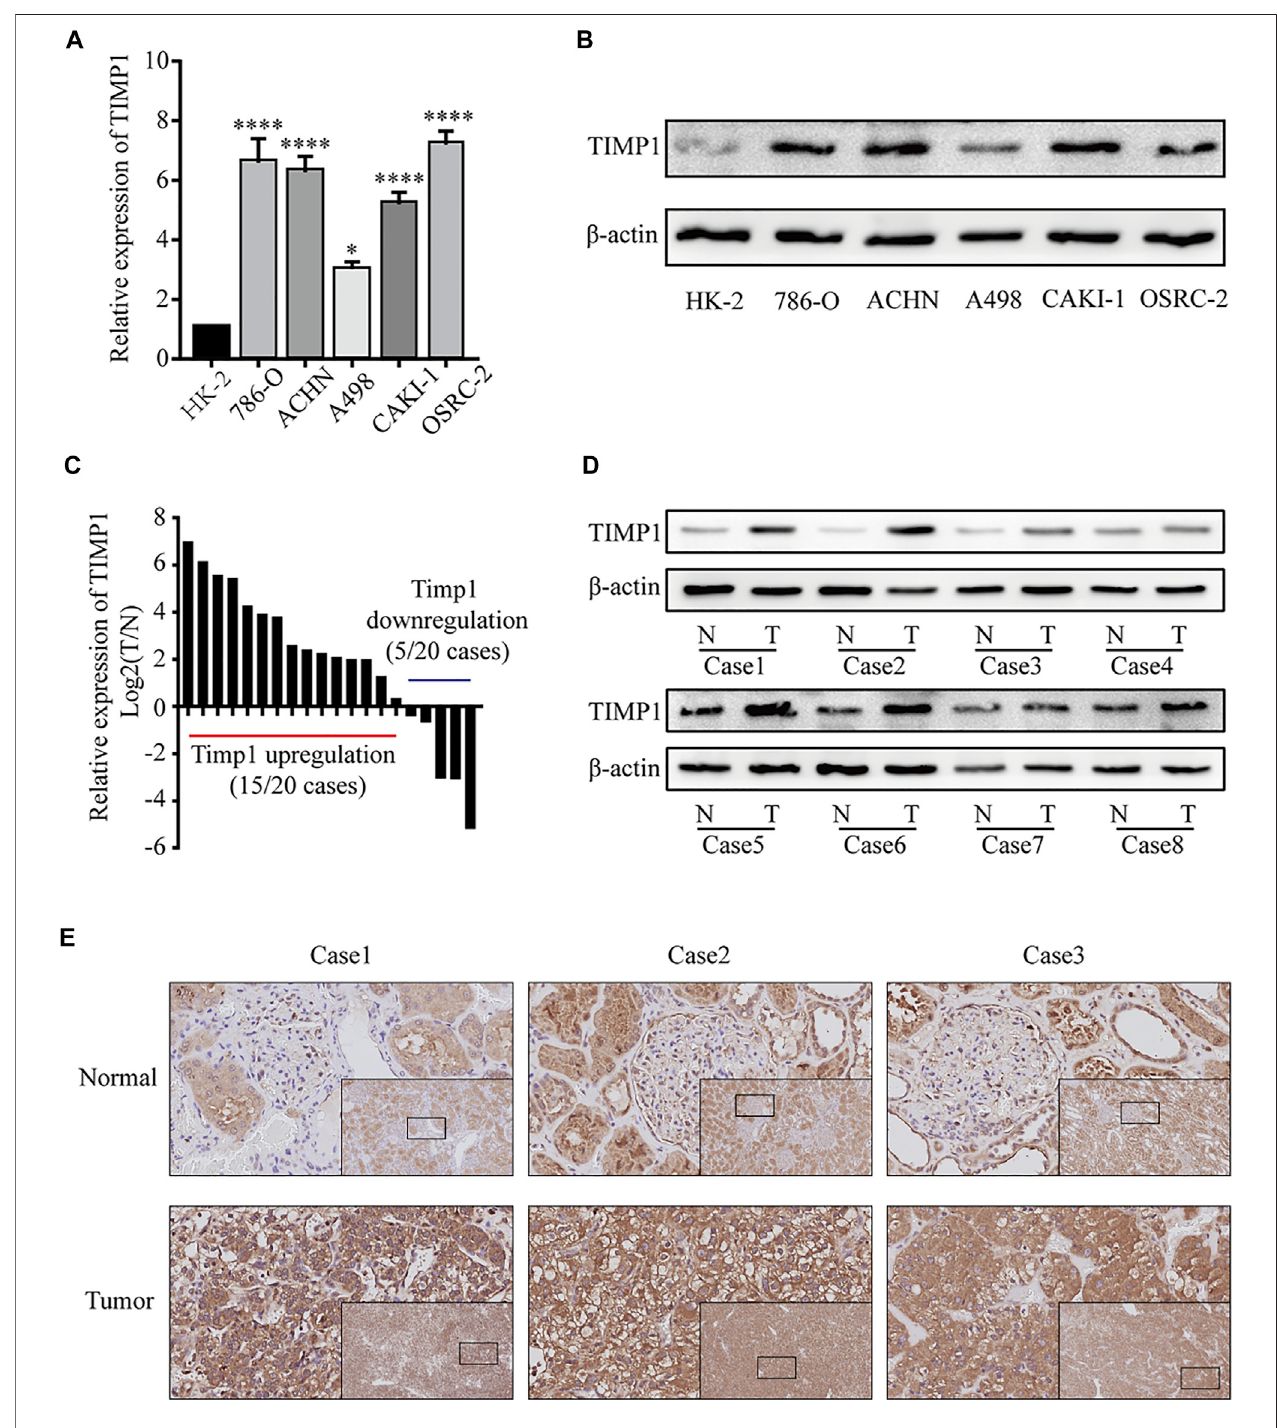
FIGURE 7 | TIMP1 was upregulated in RCC cell lines and tissues. (A) Levels of TIMP1 mRNA in 5 renal cancer cell lines (786-O, ACHN, A498, CAKI-1, OSRC-2) and anormalcell line(HK-2). (B) LevelsofTIMP1protein in5renal cancercell lines (786-O, ACHN, A498,CAKI-1,OSRC-2) and anormal cellline(HK-2). (C) The mRNA levels of TIMP1 in 20 RCC tissues and adjacent nonmalignant tissues. (D) The protein levels of TIMP1 in RCC tissues and adjacent nonmalignant tissues. (E) Immunohistochemical(IHC)stainingforTIMP1inRCCtissuesandadjacentnonmalignanttissues.Theimagesarethelowermagni fi cationofthesametissueasthat presented in the larger image of each set. Magni fi cation, ×100 and ×400. TIMP1 expression was normalized to β -actin expression. **** p < 0.0001; * p < 0.05. TIMP1, Tissue inhibitor matrix metalloproteinase 1 RCC, clear cell renal cell carcinoma.